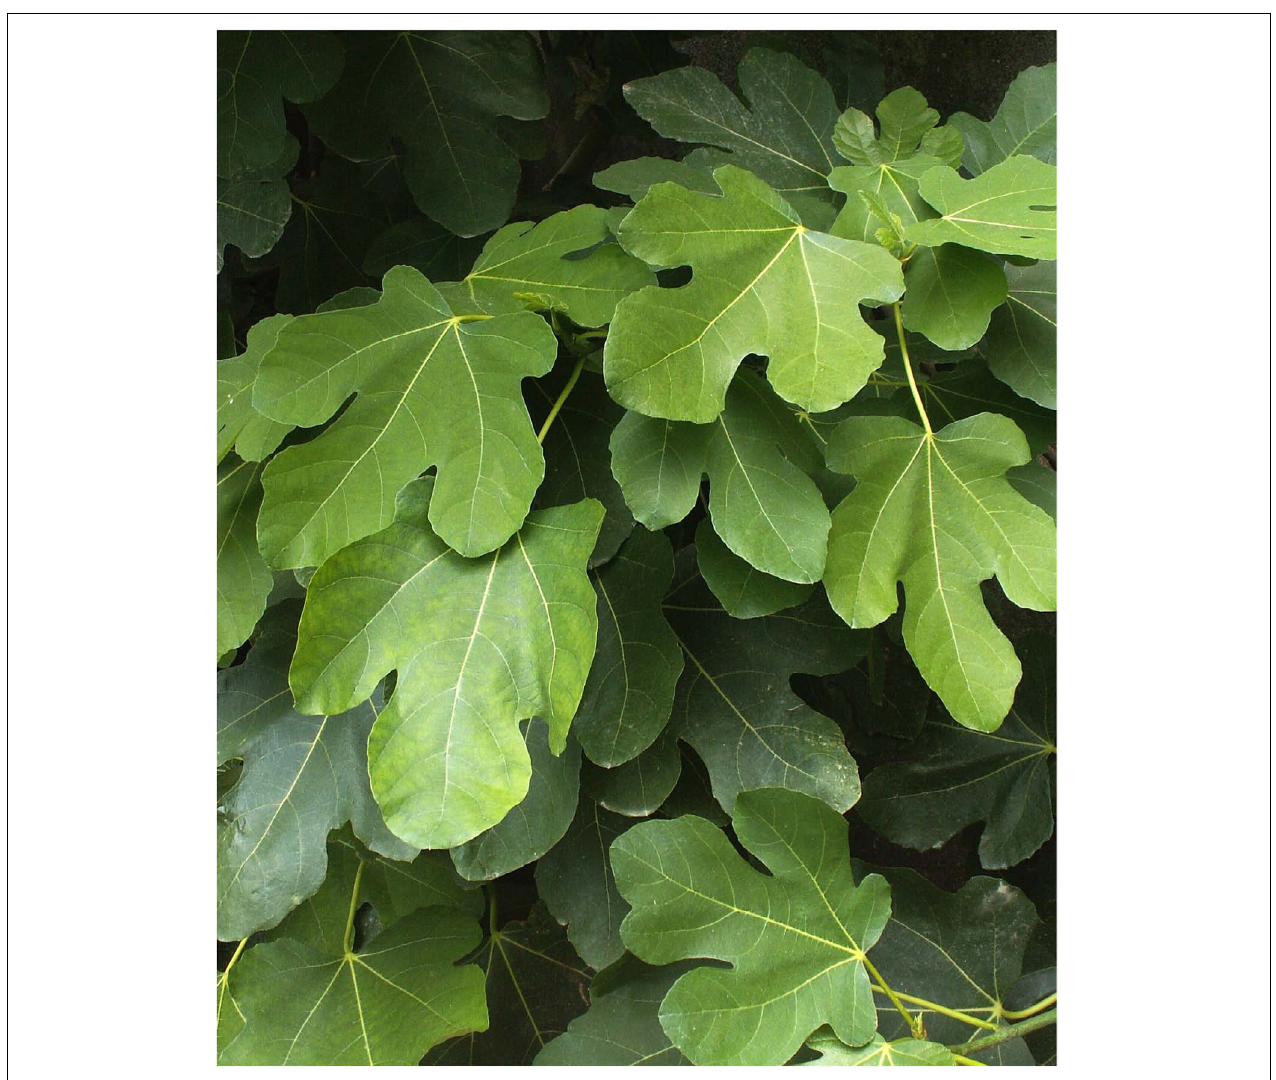
FIGURE 8 | Mediterranean Fig—a non-native plant that spread due to industrial warming of the river-water and now specially protected in Sheffield as “industrial